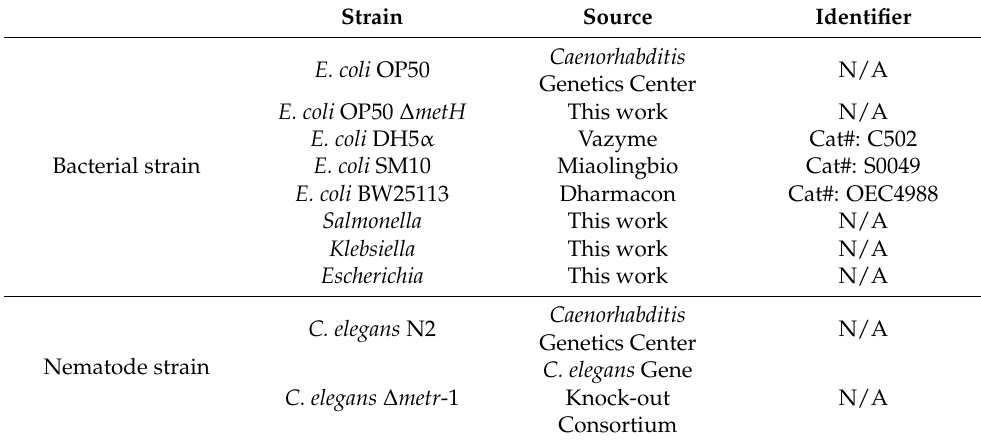
Table 2. Strains used in this